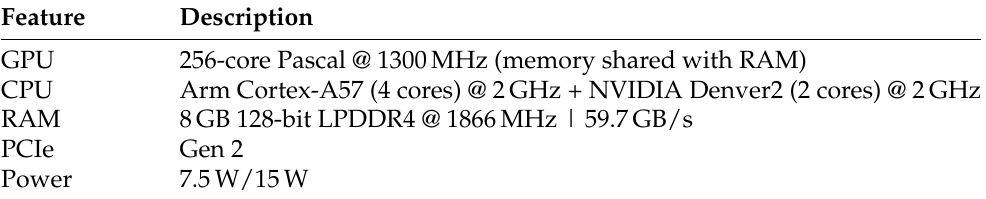
Table 1. NVIDIA Jetson TX2 technical